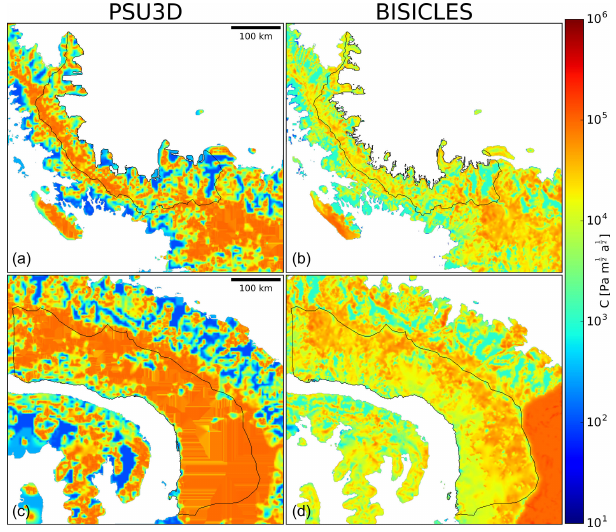
Figure 2. Inferred basal traction fields C for the Larsen C (a, b) and George VI model domains (c, d) . Black lines denote modelled drainage basins.